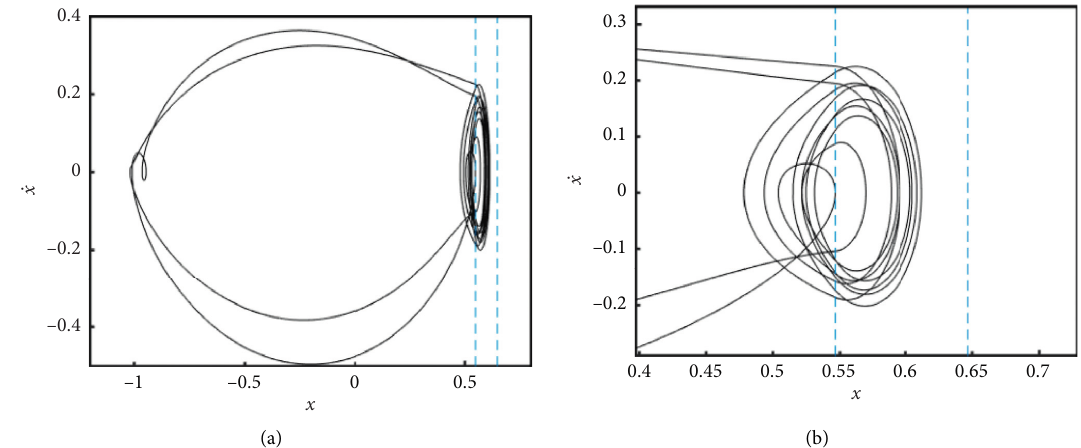
Figure 9: Phase diagram of the periodic motion. (a) 2 − 9 − 0 phase diagram of grazing periodic motion. (b) Partially enlarged view of Figure 9(a).